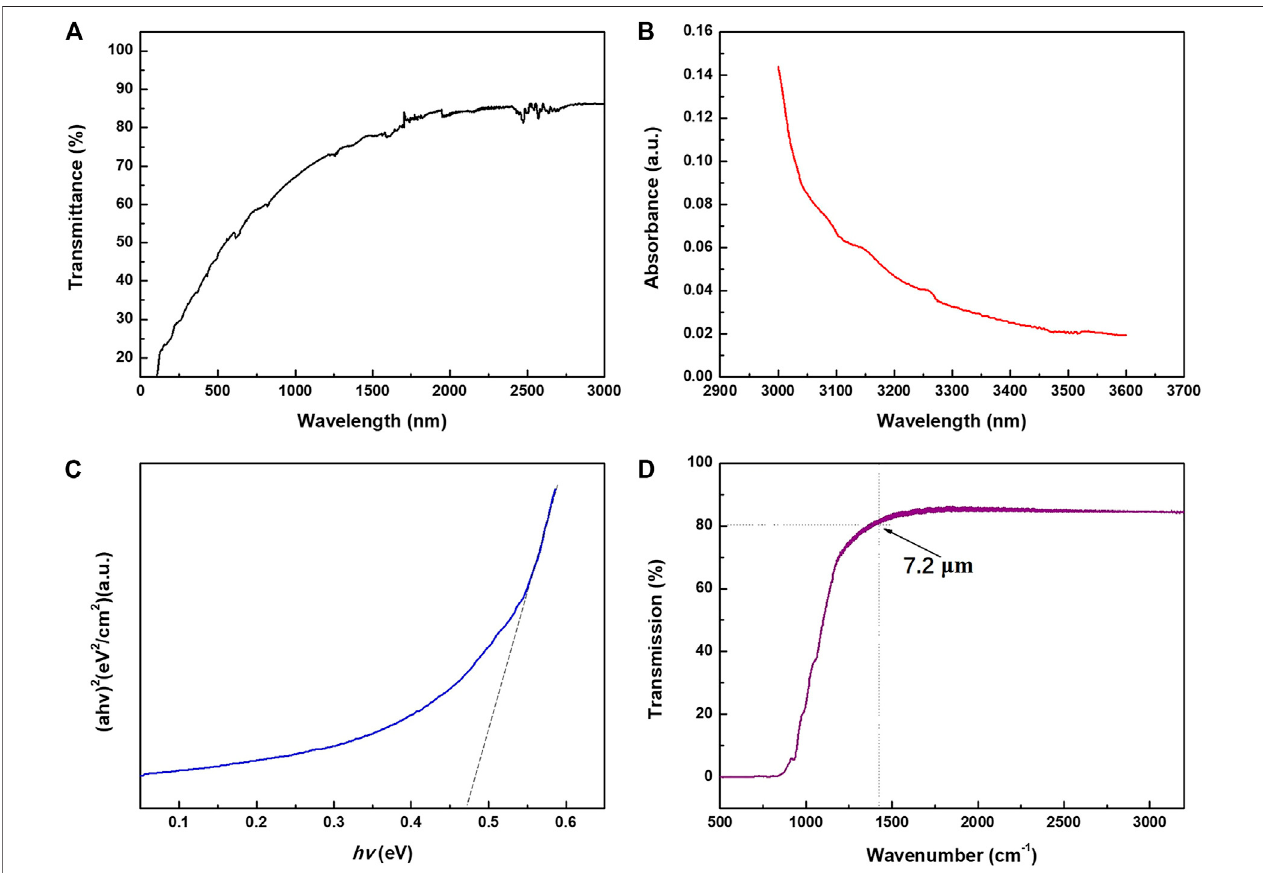
FIGURE4|(A) OpticaltransmissionspectrumofBi 2 Se 3 thin fi lm, (B) AbsorptionspectrumofBi 2 Se 3 thin fi lm, (C) ( ahv ) 2 versus hv plot,and (D) Infraredtransmission spectra of Bi 2 Se 3 thin fi